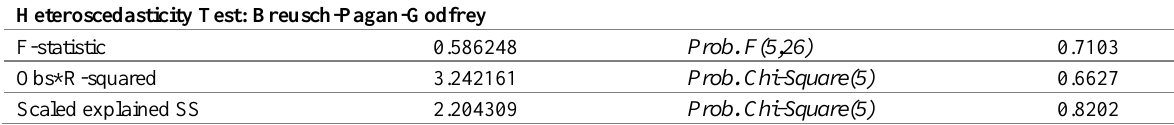
Table 4: Test Results of